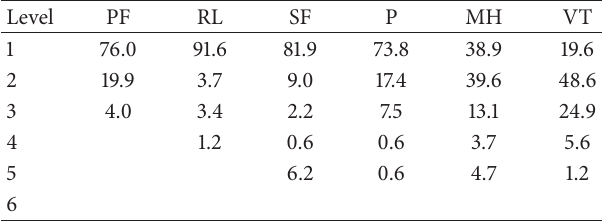
Table 3: Ceiling effects of the EQ-5D. Distribution (%) of the SF-6D health states in 321 patients with EQ-5D index score 1.